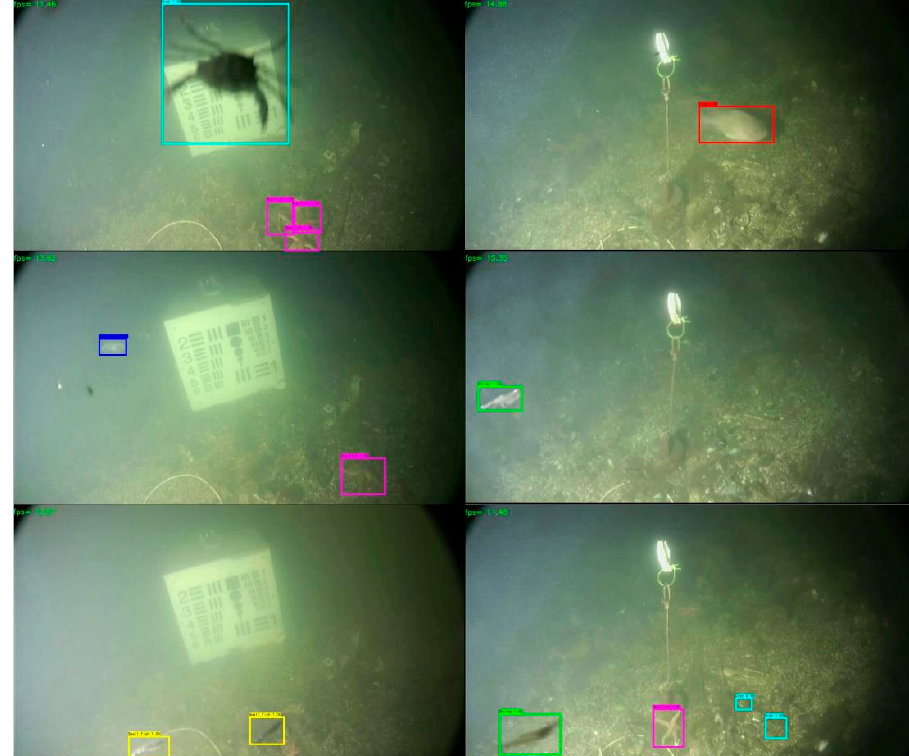
Figure 5. The detection results of our method in Brackish dataset. The detected crab in light blue box, fish in red box, jellyfish in dark blue box, shrimp in green box, small fish in yellow box and starfish in pink box.